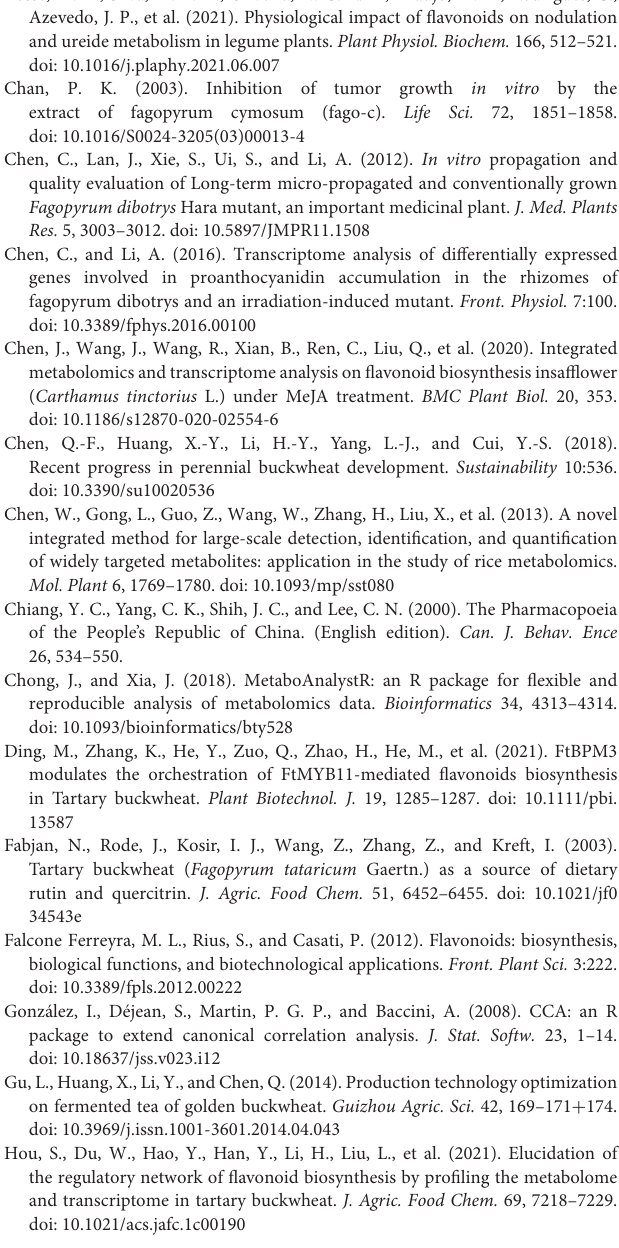
Supplementary Figure 6 | Top 20 enriched KEGG pathways of the metabolome. The rich factor is the ratio of the number of DEGs to that of all genes annotated to a pathway term. A higher rich factor indicates greater intensity. Supplementary Table 1 | List of all the primers used in this study. Supplementary Table 2 | Summary statistics of RNA sequencing results of golden buckwheat rhizomes. Supplementary Table 3 | Differentially expressed genes (DEGs) identified among the four golden buckwheat rhizomes. DESeq2 was used to identify the DEGs, and